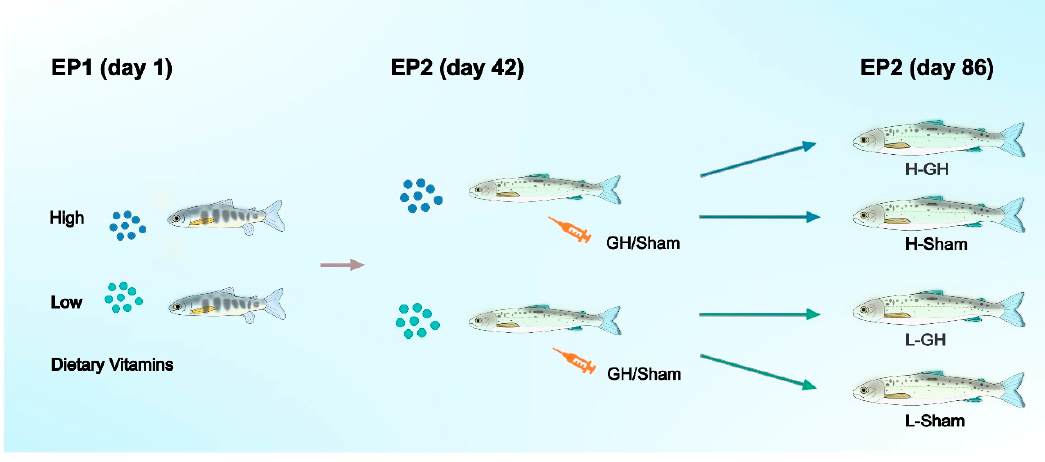
Figure 1. General flow chart of the experimental design of Atlantic salmon during EP1 and EP2.